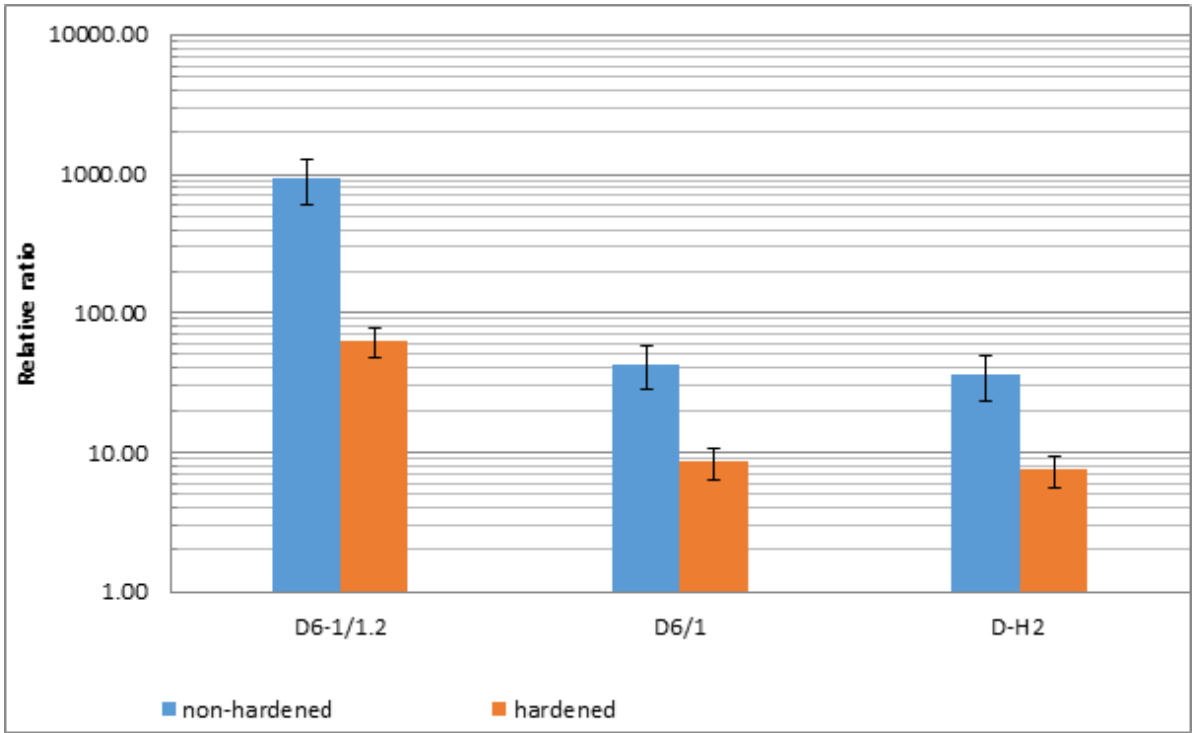
Figure 8. Relative expression levels of the Escsdp3 gene in three transgenic rape lines. Data were normalized to the reference actin 7 gene. Collecting plant material for real-time qPCR analyses was carried out at “Point 1” and “Point 2” according to the cultivation scheme shown in Figure 3a.